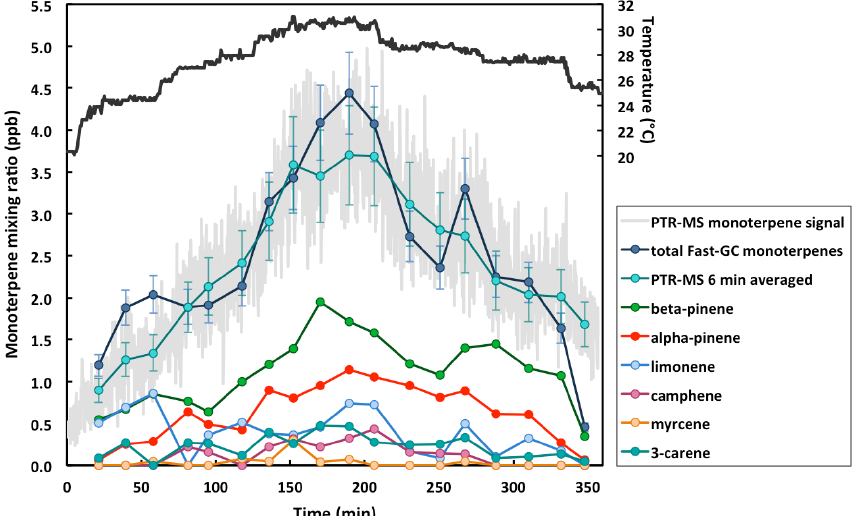
Fig. 5. Monoterpenes in white spruce emissions, as determined by Fast-GC during a plant chamber study. The GC_CHAMBER chromatog- raphy method was used to determine the monoterpene composition, at a sample frequency of 1 measurement every ∼ 17min. The sum of the individual monoterpenes measured by Fast-GC is overlaid with the simultaneously measured 15s PTR-MS total monoterpene signal, and the PTR-MS signal averaged over each 6-min Fast-GC sampling